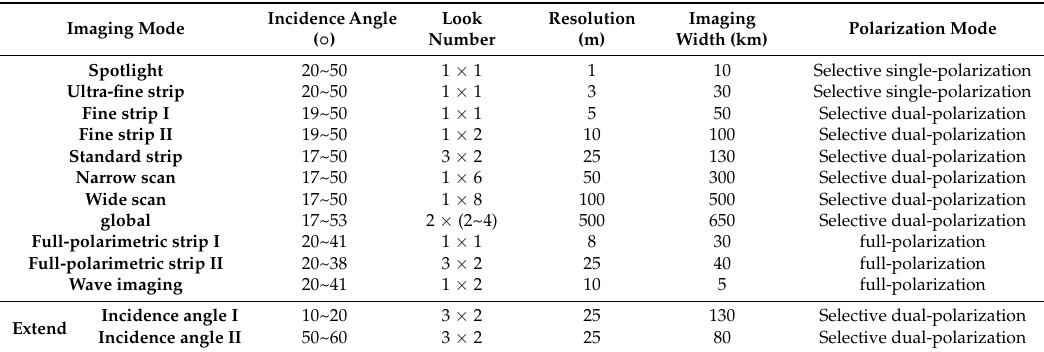
Table 1. Imaging modes and parameters of the GF-3